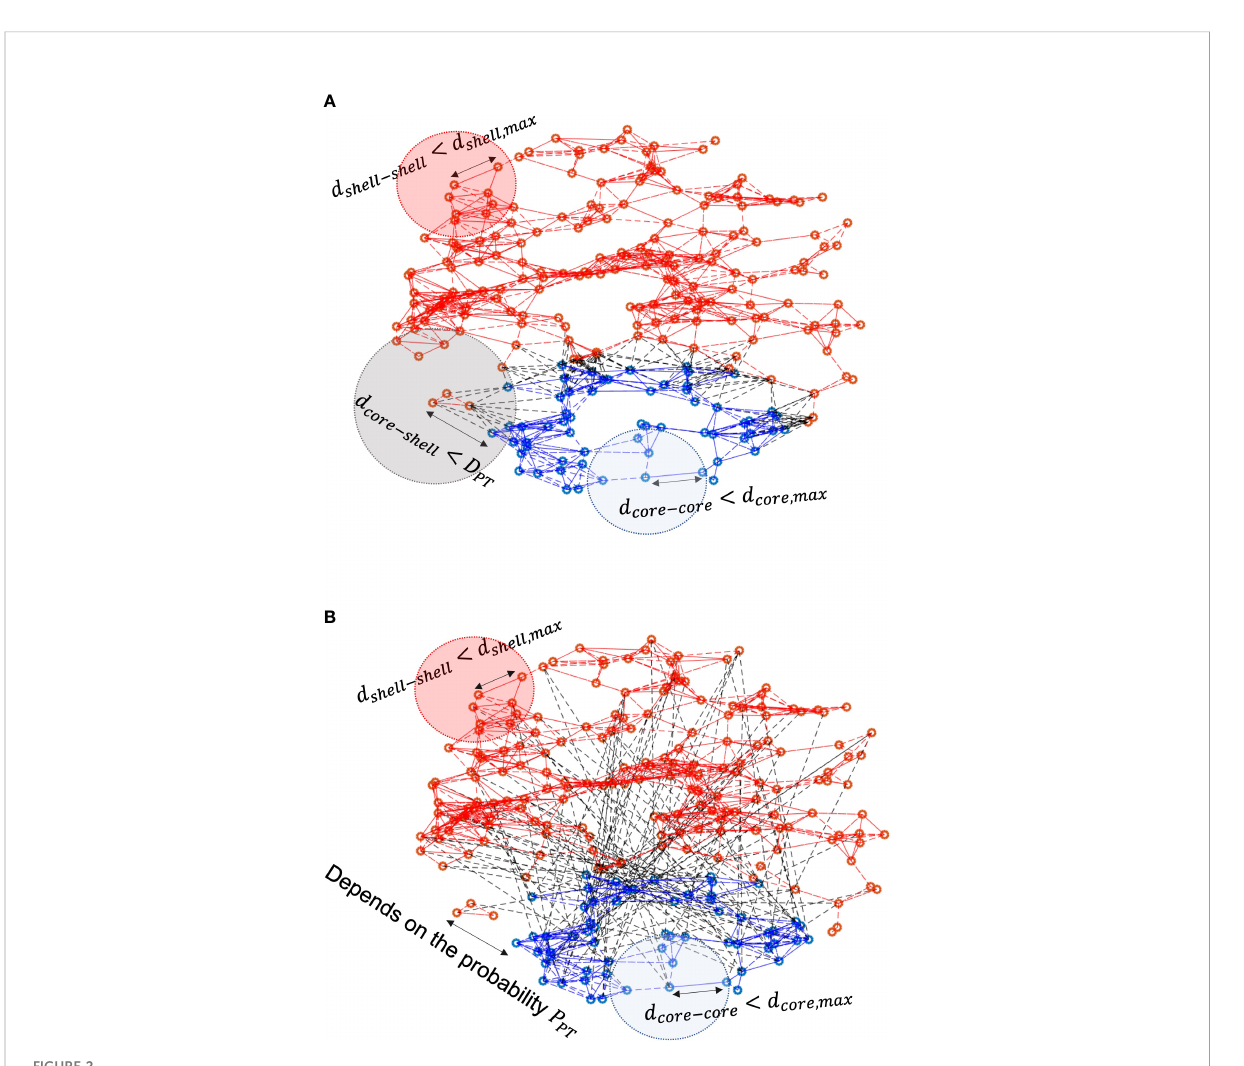
FIGURE 2 Schematics of (A) distance-dependent coupling and (B) probability-dependent coupling models. Blue dots refer to neurons in the core, and red dots refer to neurons in the shell. Red/blue lines represent intra-subpopulation couplings within the core and the shell, while black dashed lines characterize inter-subpopulation couplings between the core and the shell. In the distance-dependent model, neurons in the shell sense signals from the core neurons within the threshold distance. In the probability-dependent network, neurons in the shell receive signals from the shell randomly depending on the